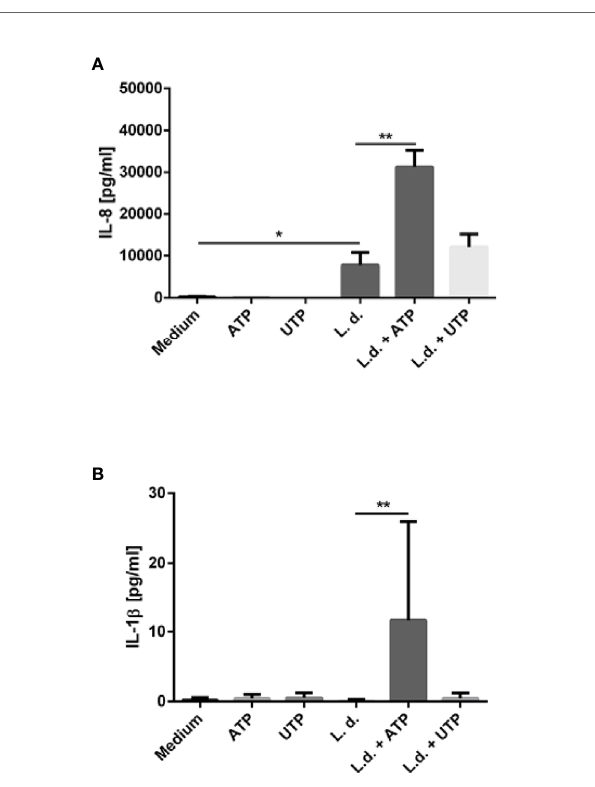
FIGURE 5 | The effect of extracellular ATP and UTP on the Leishmania -induced cytokine production by neutrophils. Primary human neutrophils were infected with L. donovani promastigotes (ratio 1:10) for 3 h at 37°C, 5% CO 2 . After removing the free, non-ingested parasites the infected cells were treated with ATP, UTP or left untreated for 18 h. The IL-8 content (A) and the IL-1 b (B) content of the supernatants was analyzed by ELISA. n=3, *p ≤ 0,05, **p ≤